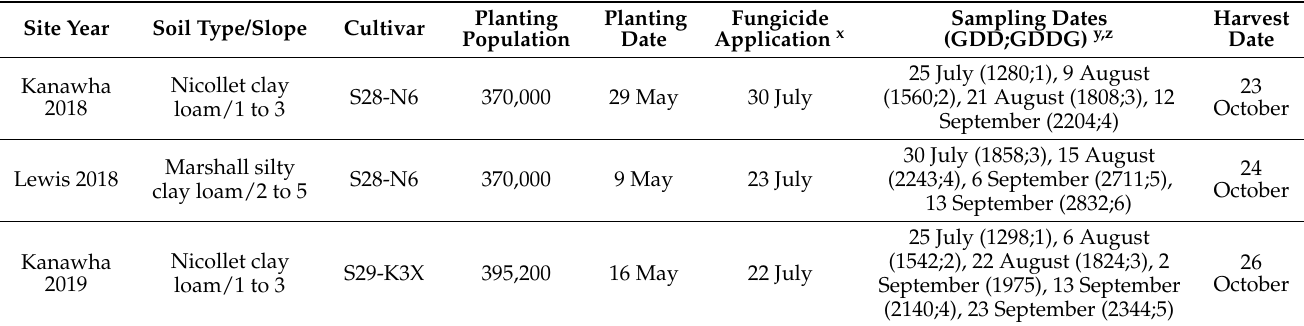
Table 1. Location, cultivar, and other details of field experiments evaluating the impact of frogeye leaf spot and fungicide treatments on radiation use